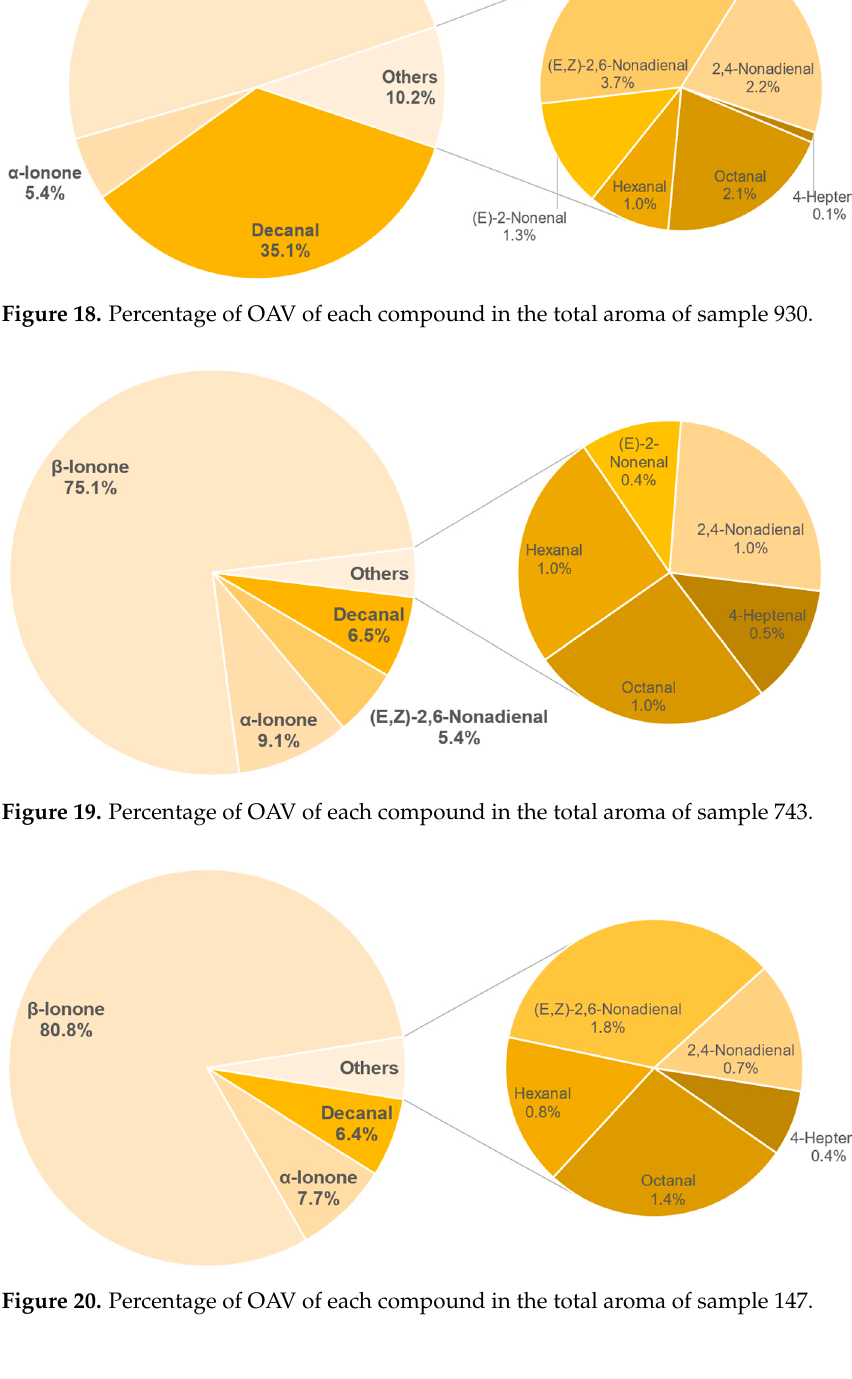
Figure 18. Percentage of OAV of each compound in the total aroma of sample 930.